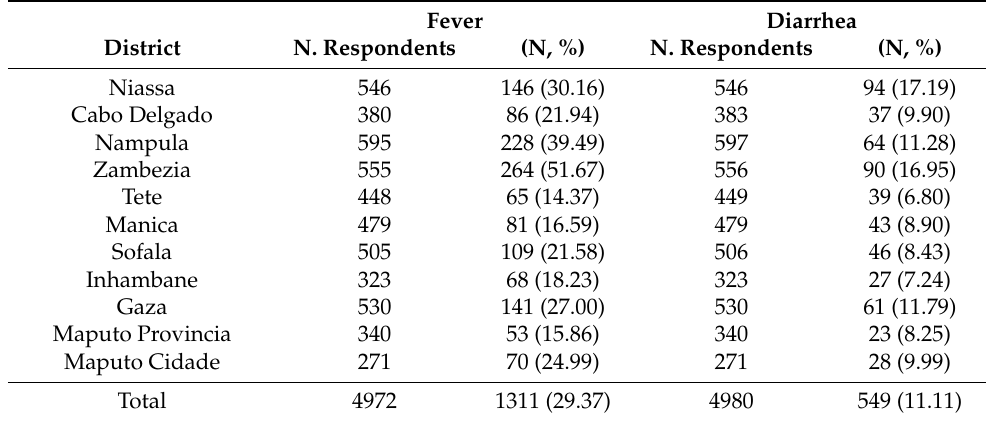
Table A2. Summary of the observed (weighted) prevalence rates of fever and diarrhoea per province in